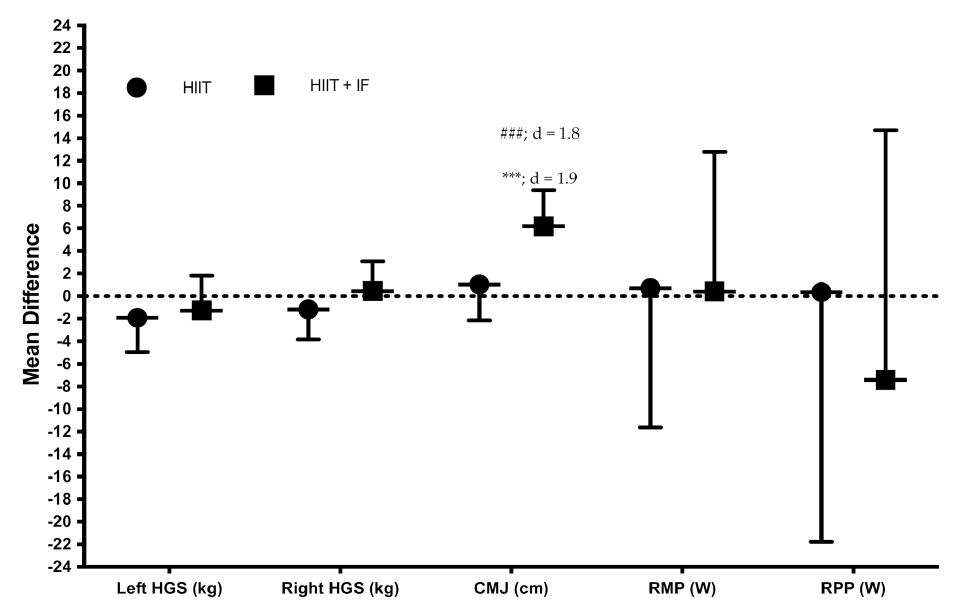
Figure 5. Effects of training on performance (mean difference post-training vs. pre-training: mean ± standard deviation). d, effect size, *** = p < 0.001 significant differences between pre- and post- training; ### = p < 0.001 significant differences between groups after